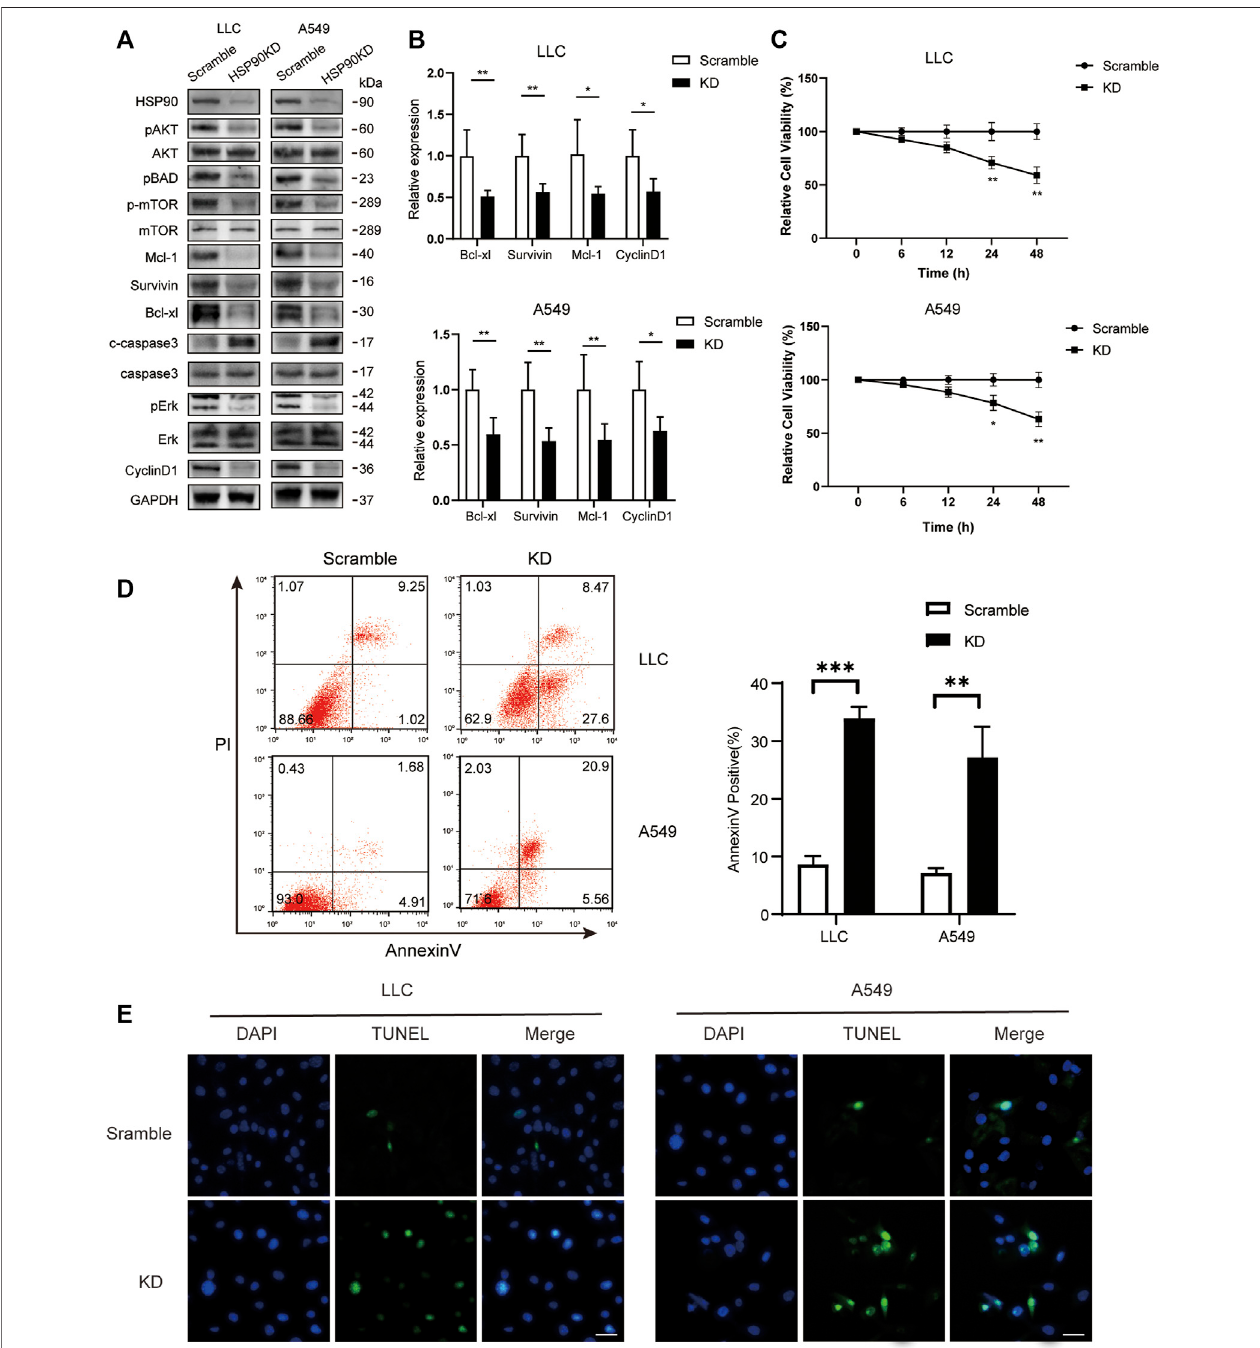
FIGURE 6 | Knocking down of HSP90 inhibited lung cancer proliferation and induced cell apoptosis. LLC and A549 cells were transfected with HSP90 siRNA or control siRNA. (A) Western blotting with indicated antibodies was performed. (B) The total RNA ofthe cellswasextracted, and aqPCR method wasadopted to test the transcription level of indicated genes. (C) Time-course analysis of the cell growth detected by MTS assay. * p < 0.05, ** p < 0.01. (D) The apoptosis level of the cells was evaluatedbystainingwithPIand AnnexinV-FITCantibodyandsubjectedby fl owcytometry.ThecolumnsshowedthestatisticalFACSresultsofthreeindependent experiments. ** p < 0.01, *** p < 0.001. (E) Analysis of apoptosis by TUNEL staining (blue fl uorescence, DAPI staining for nuclei; green fl uorescence, TUNEL-positive staining) in LLC and A549 cells. Scale bar (cid:1) 30 μ m.